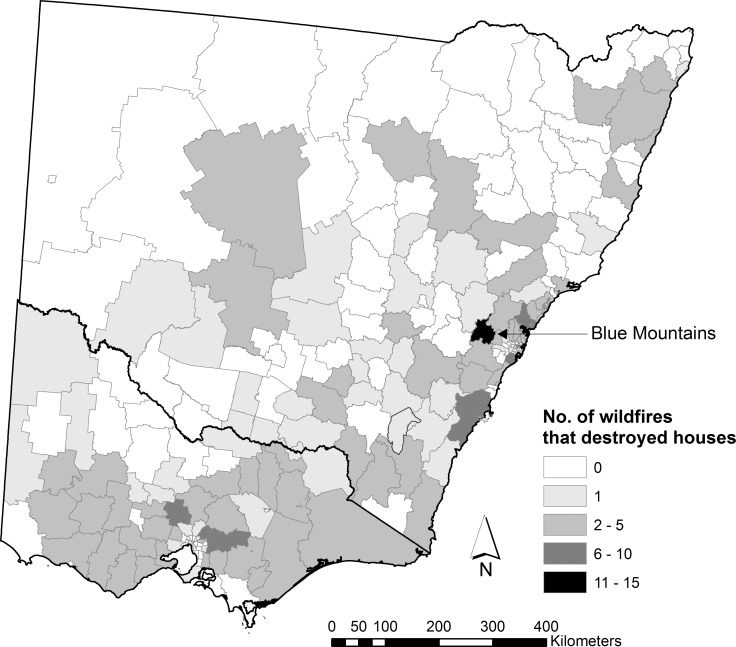
The number of wildfires that destroyed houses from 1951 to 2015 by local government area.Developed using Administrative Boundaries produced by PSMA Australia Limited licensed by the Commonwealth of Australia under Creative Commons Attribution 4.0 International licence (CC BY 4.0).